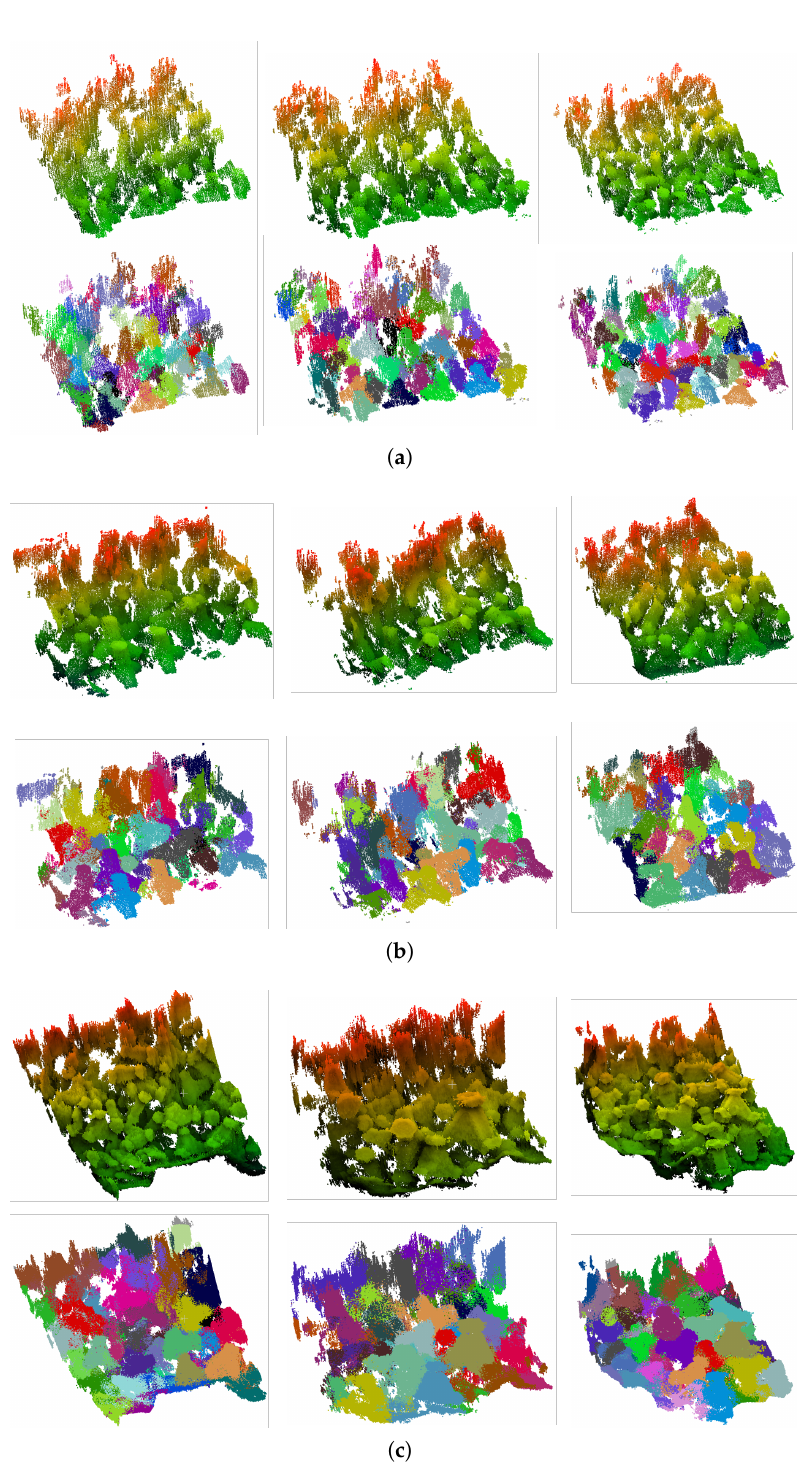
Figure 13. Visualization of instance segmentation results on MBES data. The first row of Sawara port ( a ), Todohokke port ( b ) and Era port ( c ) is the original point cloud measured by MBES. The second row of each subfigure is the predicted results of instance segmentation. Different colors represent different